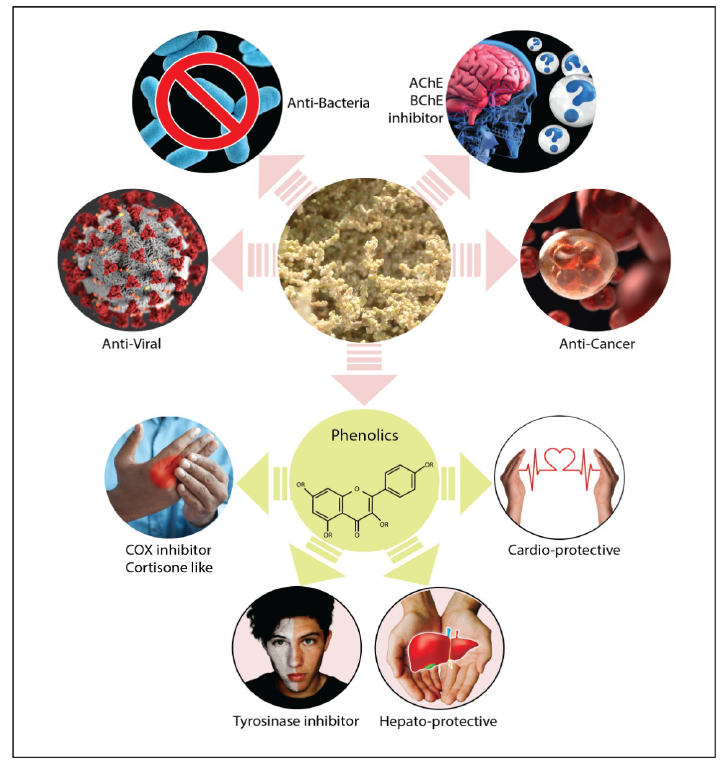
Figure 19. Important biological activities of genus Salsola